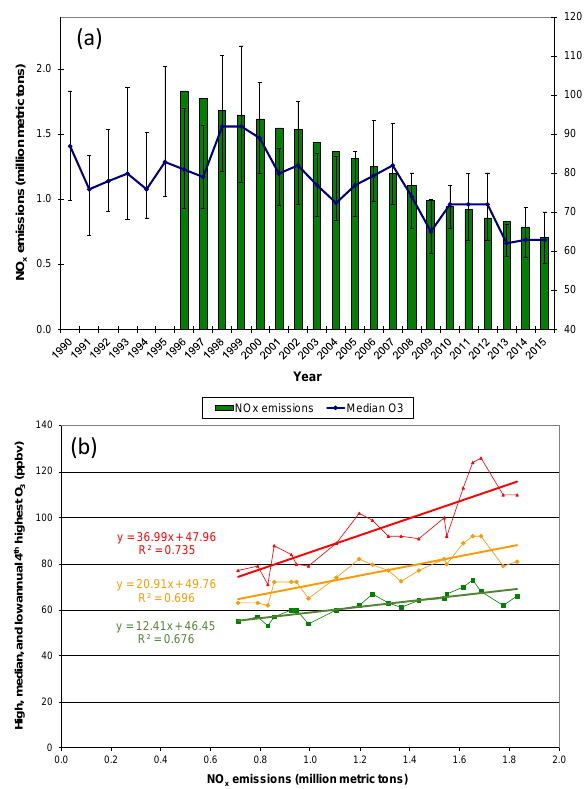
Figure 2. Comparison of annual fourth-highest daily peak 8h O 3 to NO x emissions in Georgia and Alabama (a) trends ( ± 90th and 10th percentile sites) and (b) regressions (high = 90th percentile site, median, and low = 10th percentile site annual fourth-highest daily peak 8h O 3 ). NO x emissions are from all source sectors (see Supplement). O 3 data include all EPA AQS monitors in Georgia and Alabama for each year having at least 75% data completeness (mean = 55 monitors, low of 32–36 in 1990–1993). Slopes and in- tercepts are statistically significant ( p < 0.0001).